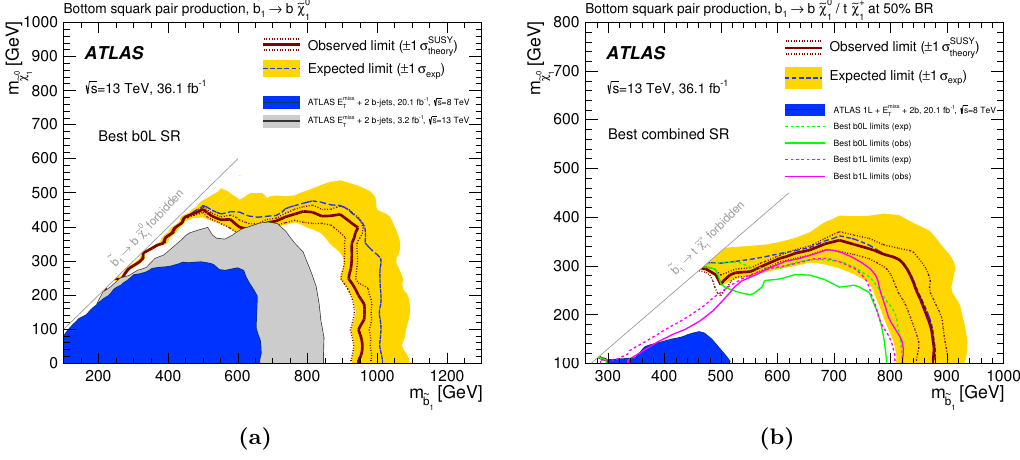
Figure 7. (a) Observed and expected exclusion contours at 95% CL, as well as (cid:6) 1 (cid:27) variation of the expected limit, in the ~ b {~ (cid:31) 0 mass plane. The SR with the best expected sensitivity is adopted 1 1 for each point of the parameter space. The yellow band around the expected limit (dashed line) shows the impact of the experimental and SM background theoretical uncertainties. The dotted lines show the impact on the observed limit of the variation of the nominal signal cross-section by (cid:6) 1 (cid:27) of its theoretical uncertainties. (b) Same, for scenarios where multiple decay modes are considered for bottom squarks. The statistical combination of b0L-SRs and b1L-SRs is used in this case. In (b) di(cid:11)erences between expected and observed contours around m ~ = 500 GeV arise from b 1 the one (cid:27) level discrepancy between the data and the predicted SM background contributions in b0L-SRB and